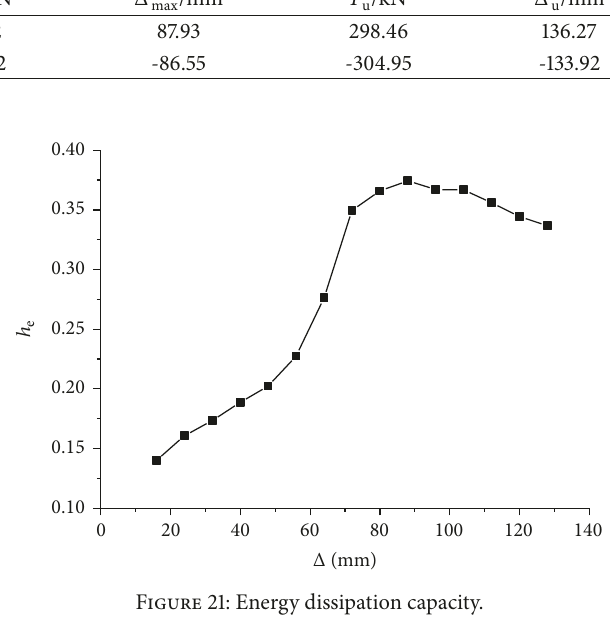
Figure 21: Energy dissipation capacity.